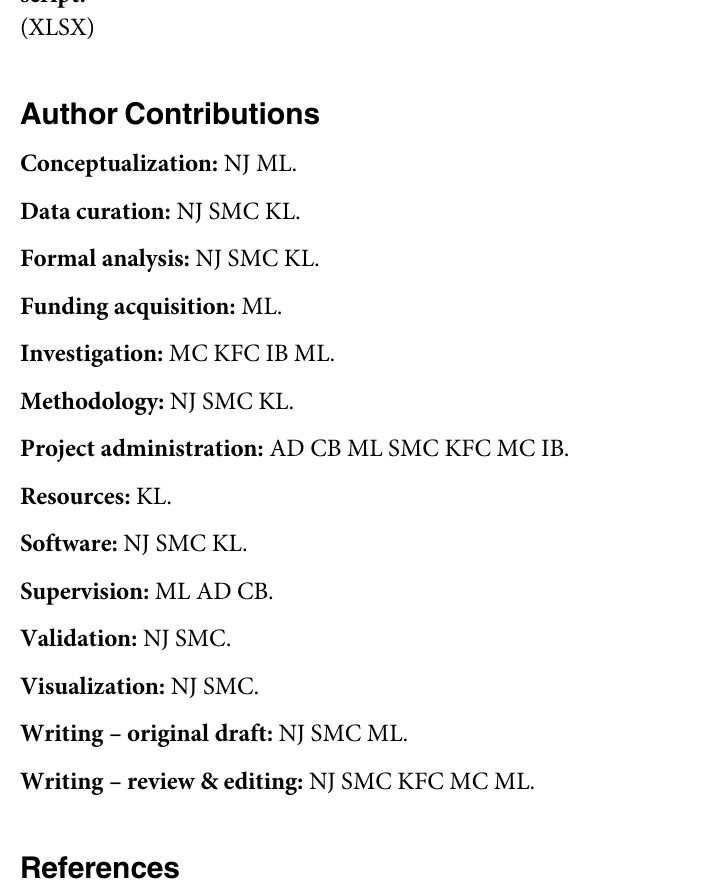
S1 Table. Excel table containing the dataset used in the analyses outlined in this manu-